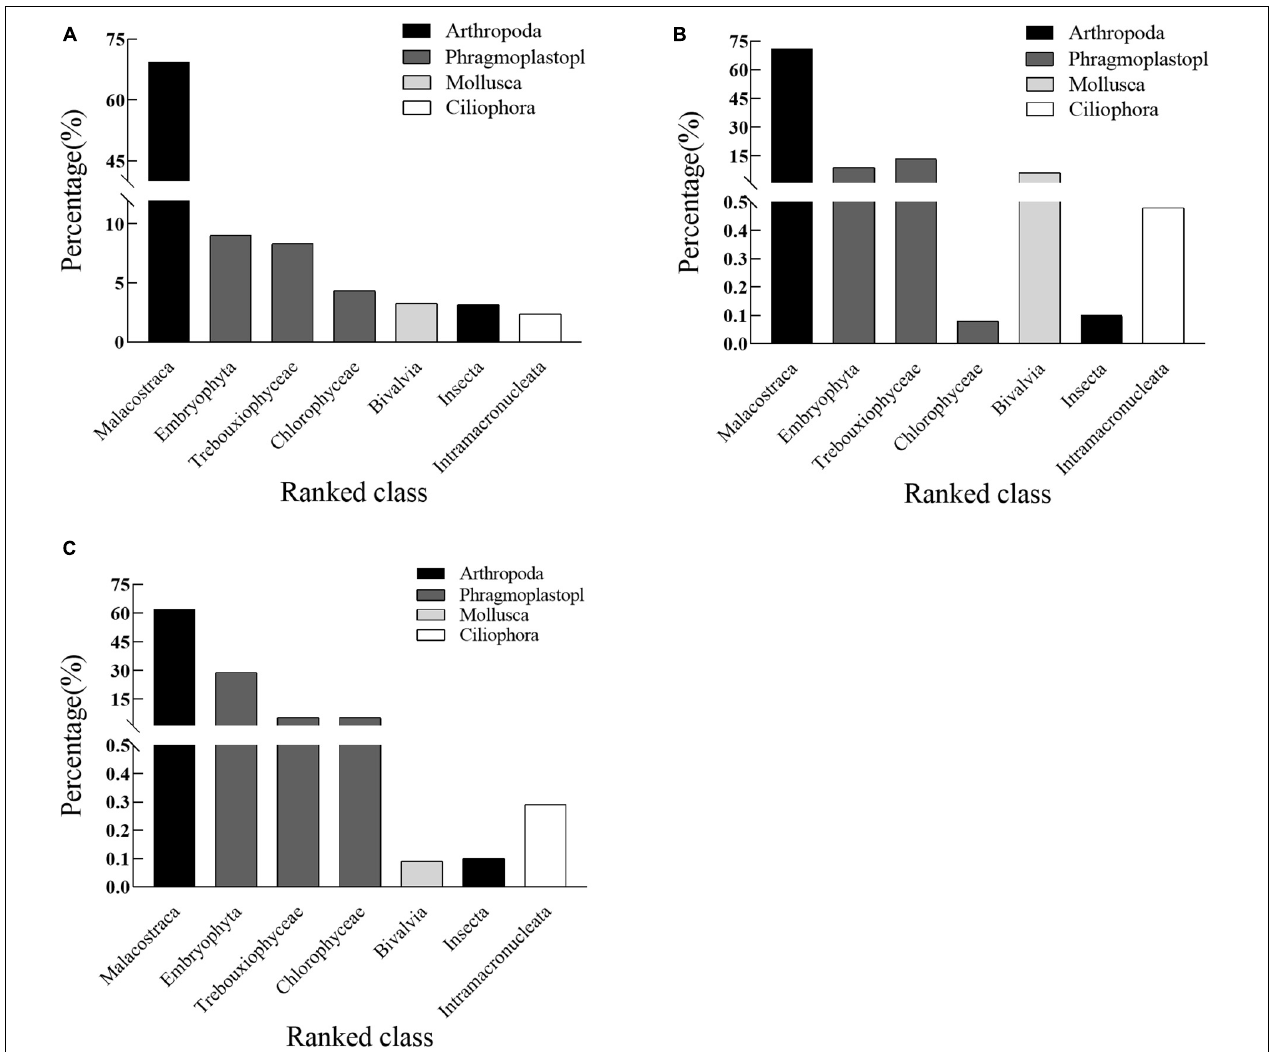
FIGURE 4 | Rank abundance of the main potential prey reads of juvenile Eriocheir sinensis crabs at the class level under (A) traditional, (B) formulated, and (C) mixture feeding modes based on 18S rDNA. Values on the bar graph represent the average.